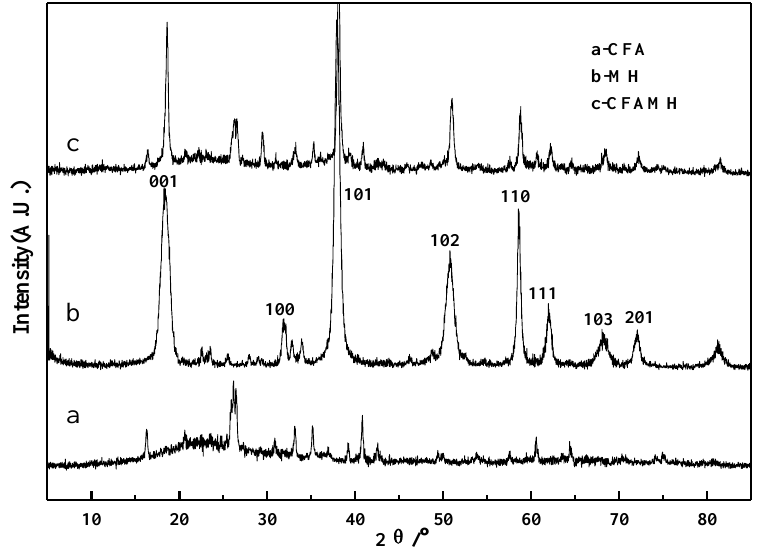
Figure 4. X-ray diffraction ( XRD) spectrum of CFA, MH and CFAMH. Table 2. Calculating data of average crystallite sizes of MH on CFAMH from the Scherrer equation. Crystal Face